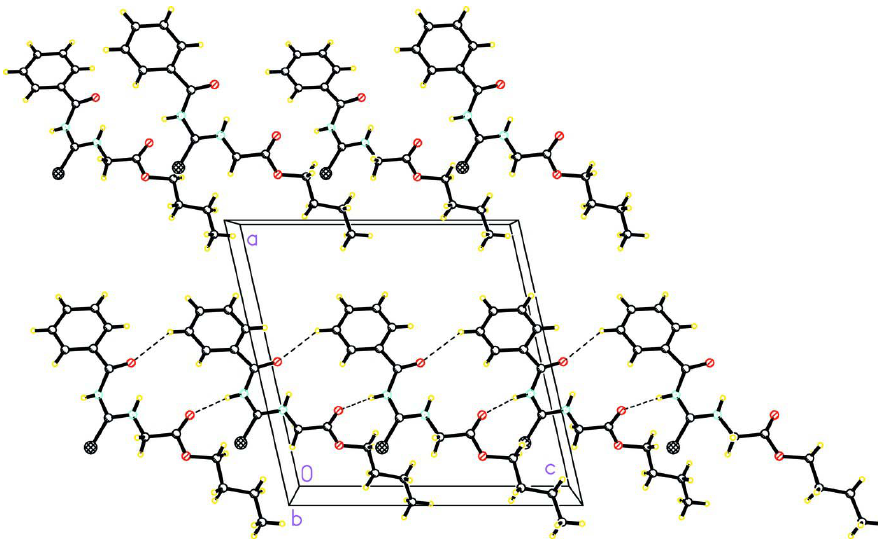
Figure 3 Crystal packing of (I) viewed down the a axis. Hydrogen bonds are drawn as dashed lines. Butyl 2-(3-benzoylthioureido)acetate Crystal